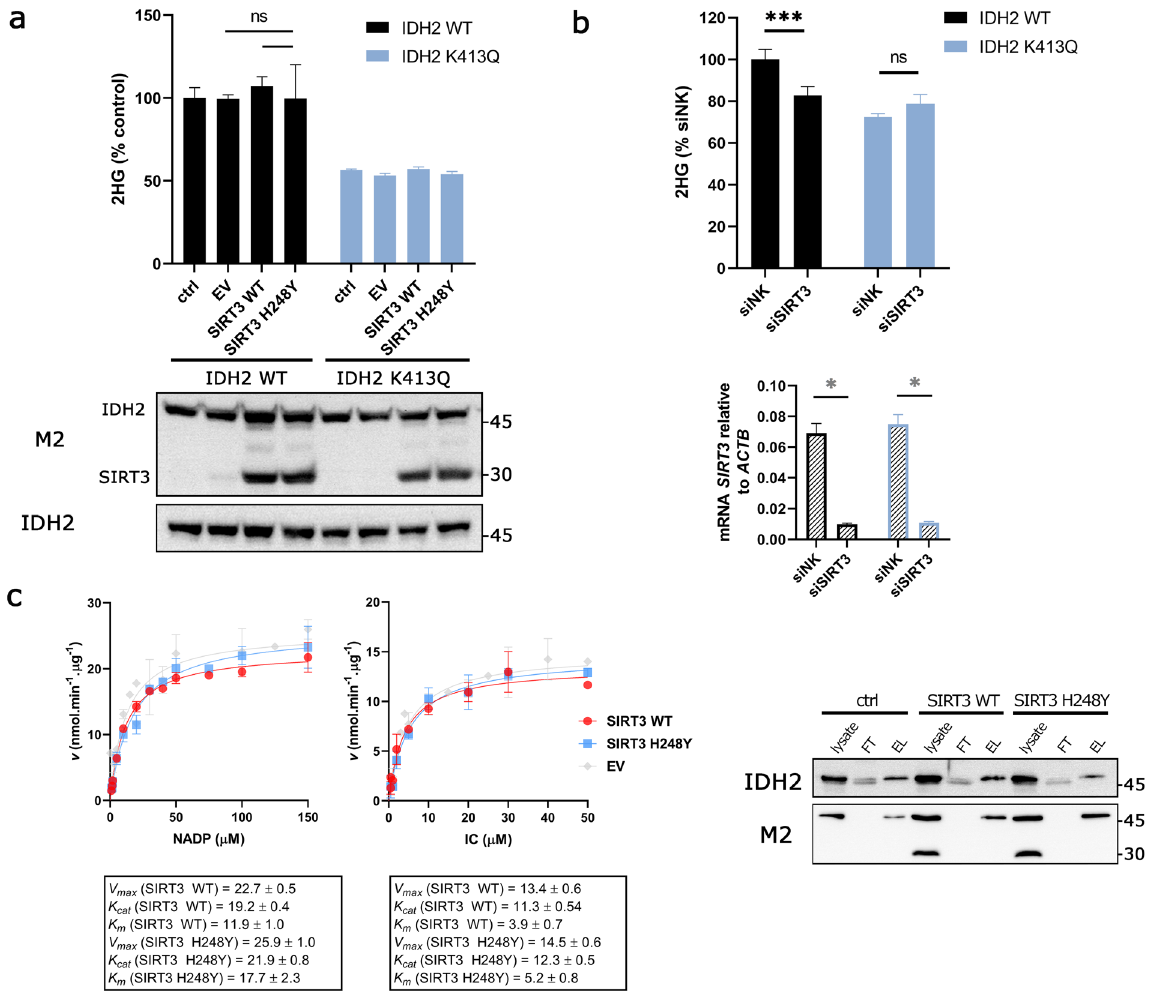
Figure 3. Role of SIRT3 in IDH2 function. (a) Cellular 2HG analysed by LC-MS from the control, pcDNA3.1 (EV), SIRT3 WT and SIRT3 H248Y-transfected cells overexpressing IDH2 WT or K413Q, respectively. Underneath there is depicted western blot of the corresponding cell lysates of the analysed samples demonstrating transfection of SIRT3 and H248Y along with IDH2 variants (both detected by anti-M2 antibody). Western blot detecting IDH2 expression in stable cell lines. N = 4. ns p = 0.4608 and p = 0.3353, respectively, calculated using one-way ANOVA Tukey´s multiple comparisons test. (b) Cell 2HG analysed by LC-MS from siSIRT3-transfected IDH2 WT and K413Q expressing cells. N > 5. *** p = 0.0001, ns p = 0.6994, calculated using one-way ANOVA Tukey´s multiple comparisons test. The graph below depicts mRNA expression analysis demonstrating silencing of SIRT3 . N = 2. * p < 0.0001 calculated using the Unpaired t-test. (c) Michaelis-Menten plots for IDH2 NADP + -driven IDH2-mediated NADPH formation as dependent on concentrations of NADP + and isocitrate transfected with SIRT3 WT and SIRT3 H248Y, respectively. Box contains values of V max and K m . Unit of K cat for IDH2 WT/K413Q is s − 1 ; data are expressed as mean ± s.e.m. Western blot depicts the purification of IDH2 from SIRT3 transfected or non-transfected cell lysates. Note that SIRT3 proteins tagged with 3xFLAG were not eluted with FLAG